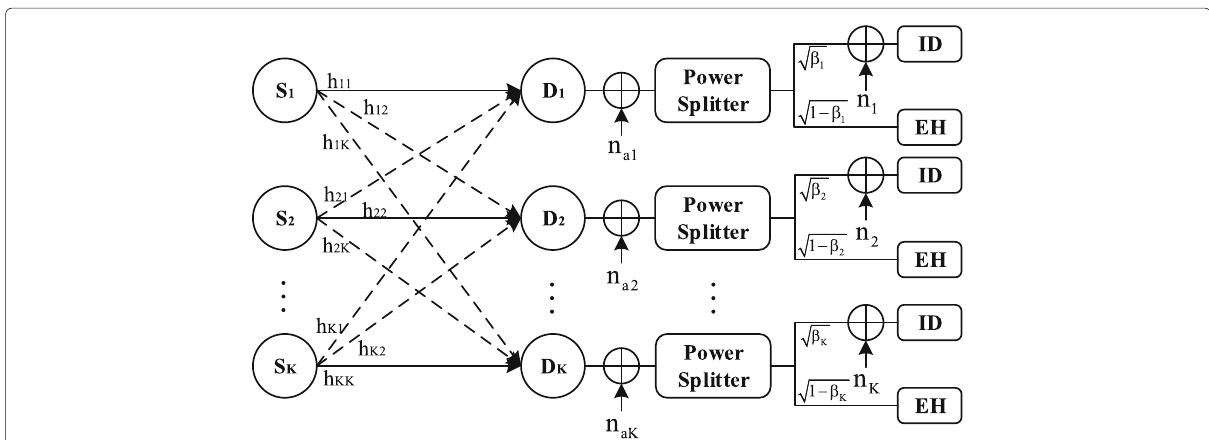
Fig. 1 The system model for SWIPT in K -user interference channels. This system include K source-destination links. Each link includes a single-antenna source node and a destination node equipped with a power splitter, which splits the received signal into two streams, one for EH and the other for ID. The solid lines represent the channel gain between the related node pairs, and the dotted lines represent the channel gain between other unrelated node pairs. The symbol n ak , k ∈ { 1,... K } represents the noise at nodes D k , and β is the PS